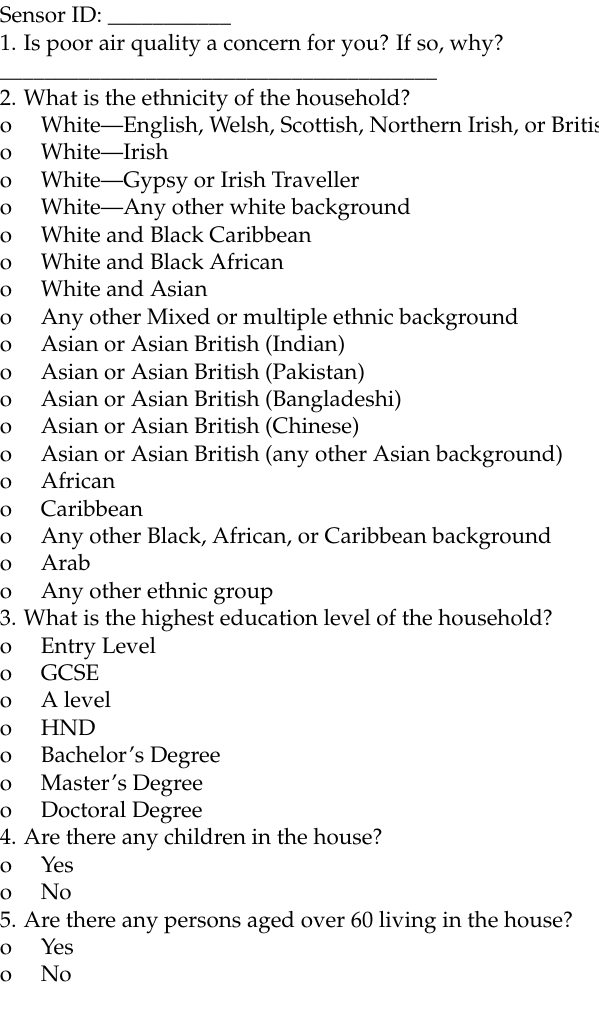
Table A1. Initial